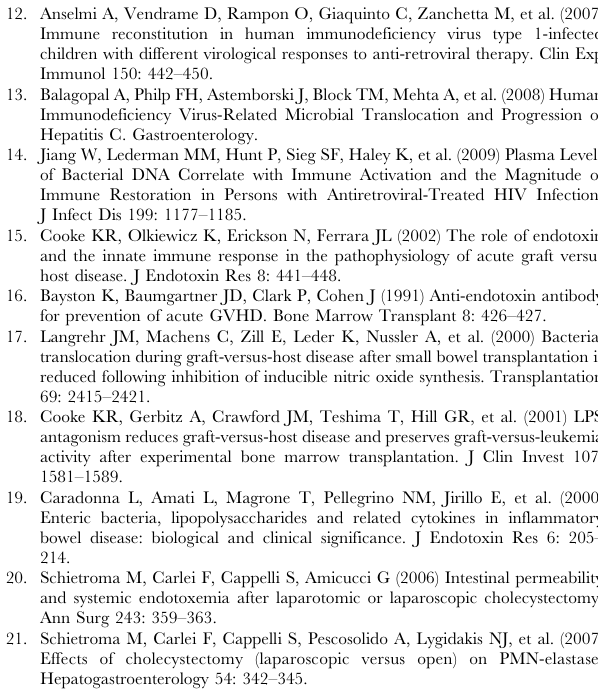
Figure S6 Spatial localization of microbial products with type I IFN a + cells in colon. Images (200 6 ) of colon stained for both E. coli (brown) and IFN a (red) from uninfected and chronically SIV- infected Non-AIDS and AIDS RMs. Found at: doi:10.1371/journal.ppat.1001052.s006 (8.30 MB TIF) Figure S7 Spatial localization of microbial products with an effector marker of immune activation, IL-18, in MesLN. Images (400 6 ) of MesLN stained for both LPS (brown) and IL-18 (red) from uninfected and SIV-infected Non-AIDS RMs. Note the spatial proximity of LPS + cells and extracellular LPS with IL-18 + cells in MesLN. Scale bars = 50 m m. Found at: doi:10.1371/journal.ppat.1001052.s007 (10.20 MB TIF) Figure S8 Damage to the integrity of the epithelial barrier in chronic SIV + RMs. Low magnification whole tissue (top panel), 40 6 (middle panel) and 100 6 (bottom panel) images from high power whole tissue scans of colon from SIV uninfected and chronically SIV + RMs immunohistochemically stained for the tight junction protein claudin-3 (brown). Rectangles represent regions of the colon magnified in the successive images, while the rectangles displayed in the 100 6 lower panel images represent the region magnified and displayed in Figure 7. Scale bars = 1 mm. Found at: doi:10.1371/journal.ppat.1001052.s008 (4.68 MB TIF) Figure S9 GI tract damage results in PMN infiltration within the colon of chronically SIV + RM. (A) Representative images (200 6 ) of the colon stained for myeloperoxidase (brown) as a marker for PMNs. Note the increasing accumulation of myelo- peroxidase + PMNs adjacent to epithelial lesions in chronically SIV + RM, reflecting a tissue response to loss of epithelial integrity, but the lack of this association seen in early acute SIV + RM (4 dpi). (B) Random high power 400 6 images (10–15) of gut LP were taken and the percent area staining for myeloperoxidase (PMN) were determined in early/acute and chronic SIV + RM.